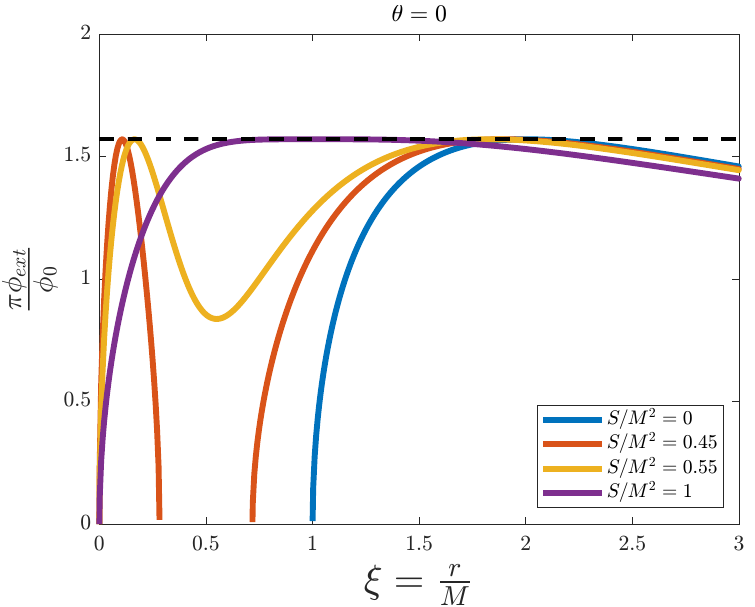
Figure 4. External magnetic flux πφ ext / φ 0 versus the adimensional distance ξ = r / M for the simulation of a Kerr black hole with fixed θ = 0, and for different values of B = S / M 2 . The dashed line represents the threshold value πφ ext / φ 0 = π